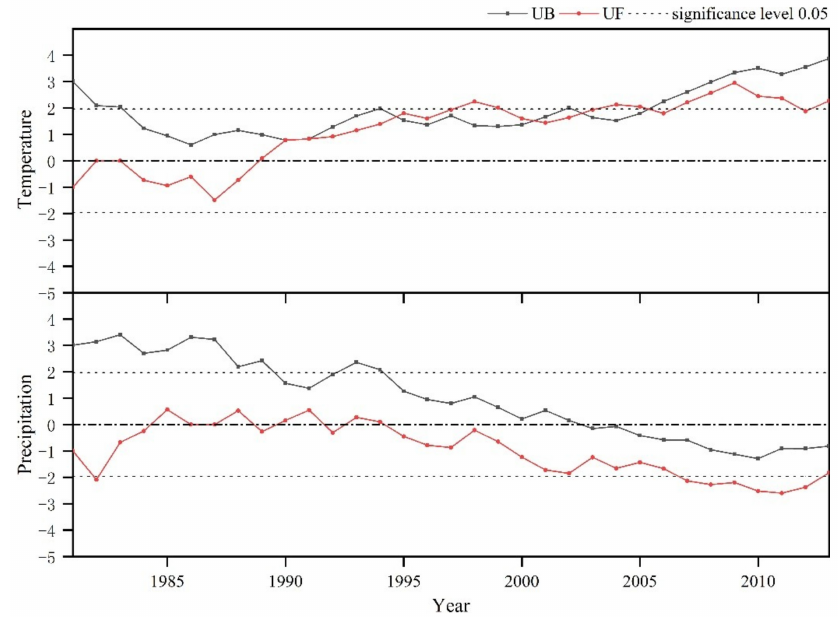
Figure 5. The Mann–Kendall (M-K) method analysis results of the annual average temperature and